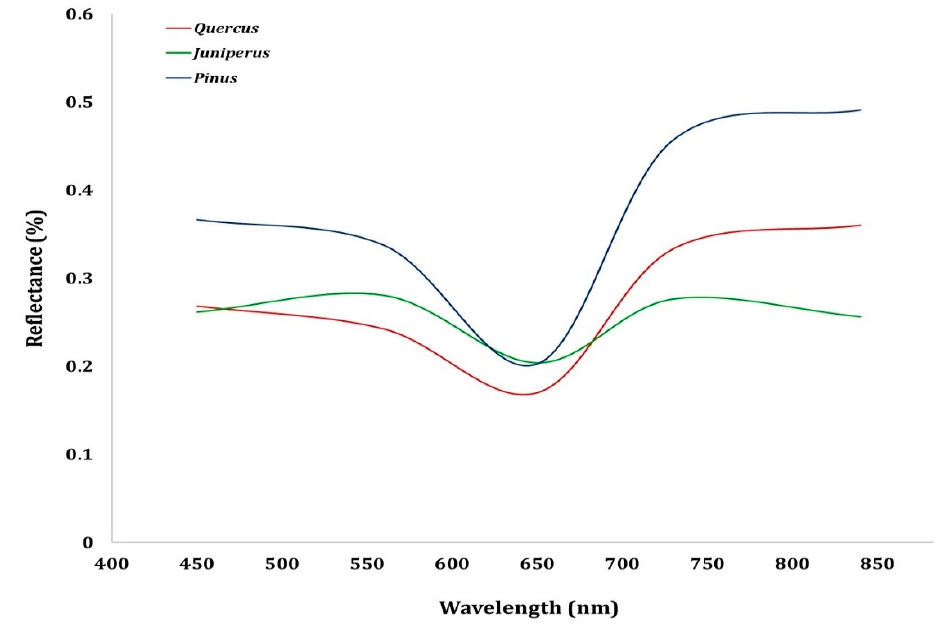
Figure 6. Spectral reflectance at different wavelengths in the crowns of three different